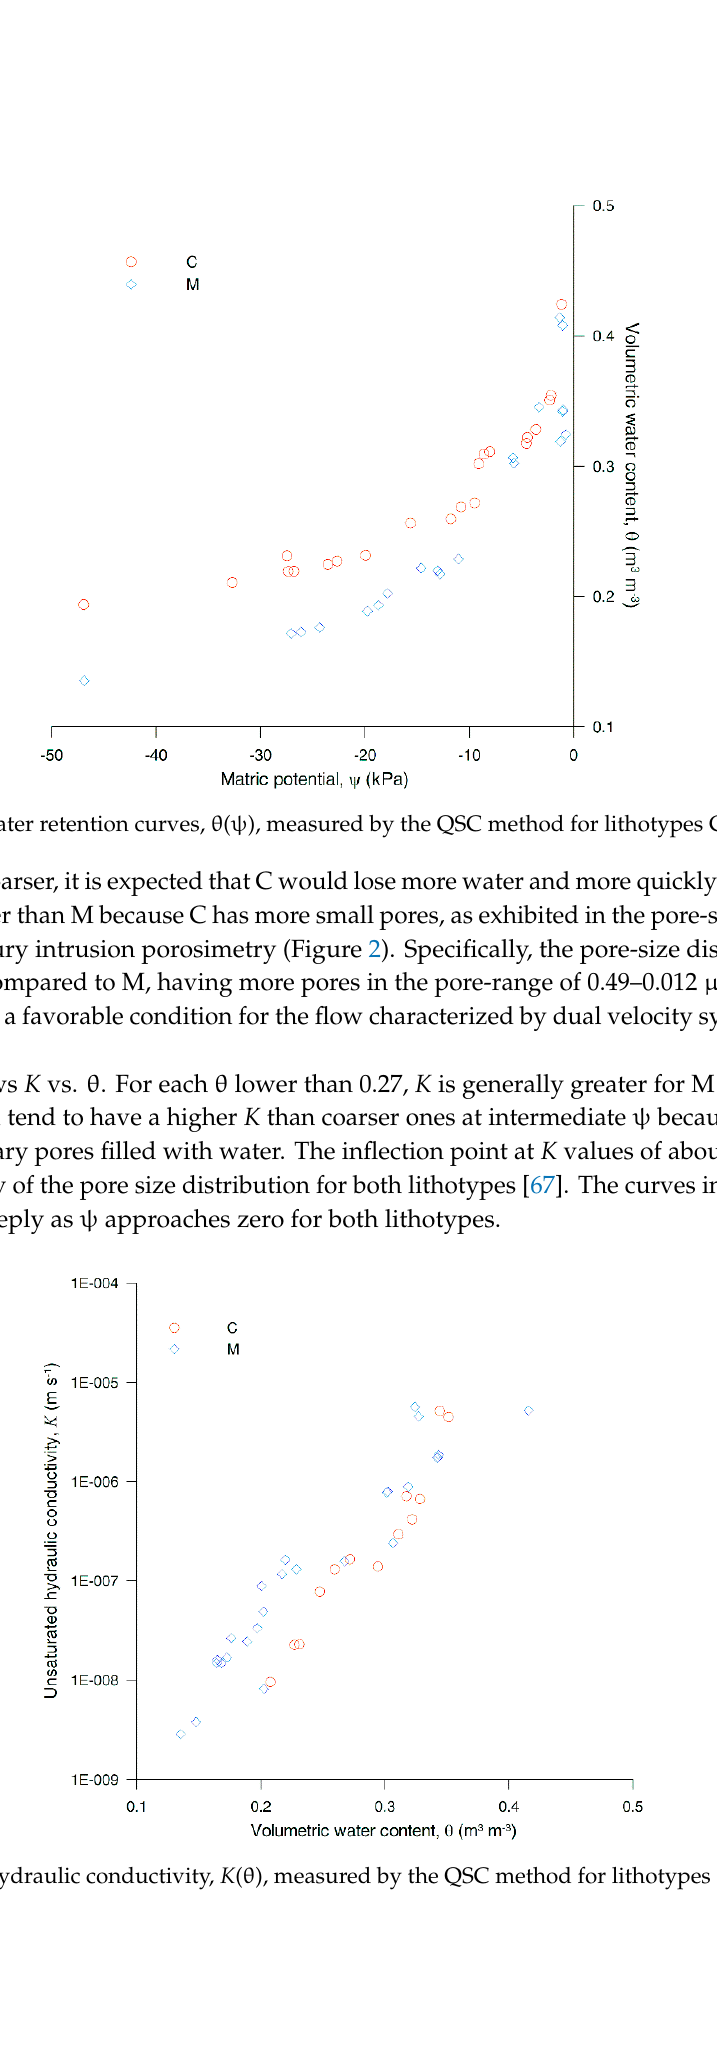
Figure 11. Hydraulic conductivity, K ( ψ ), measured by the QSC method for lithotypes C and M.